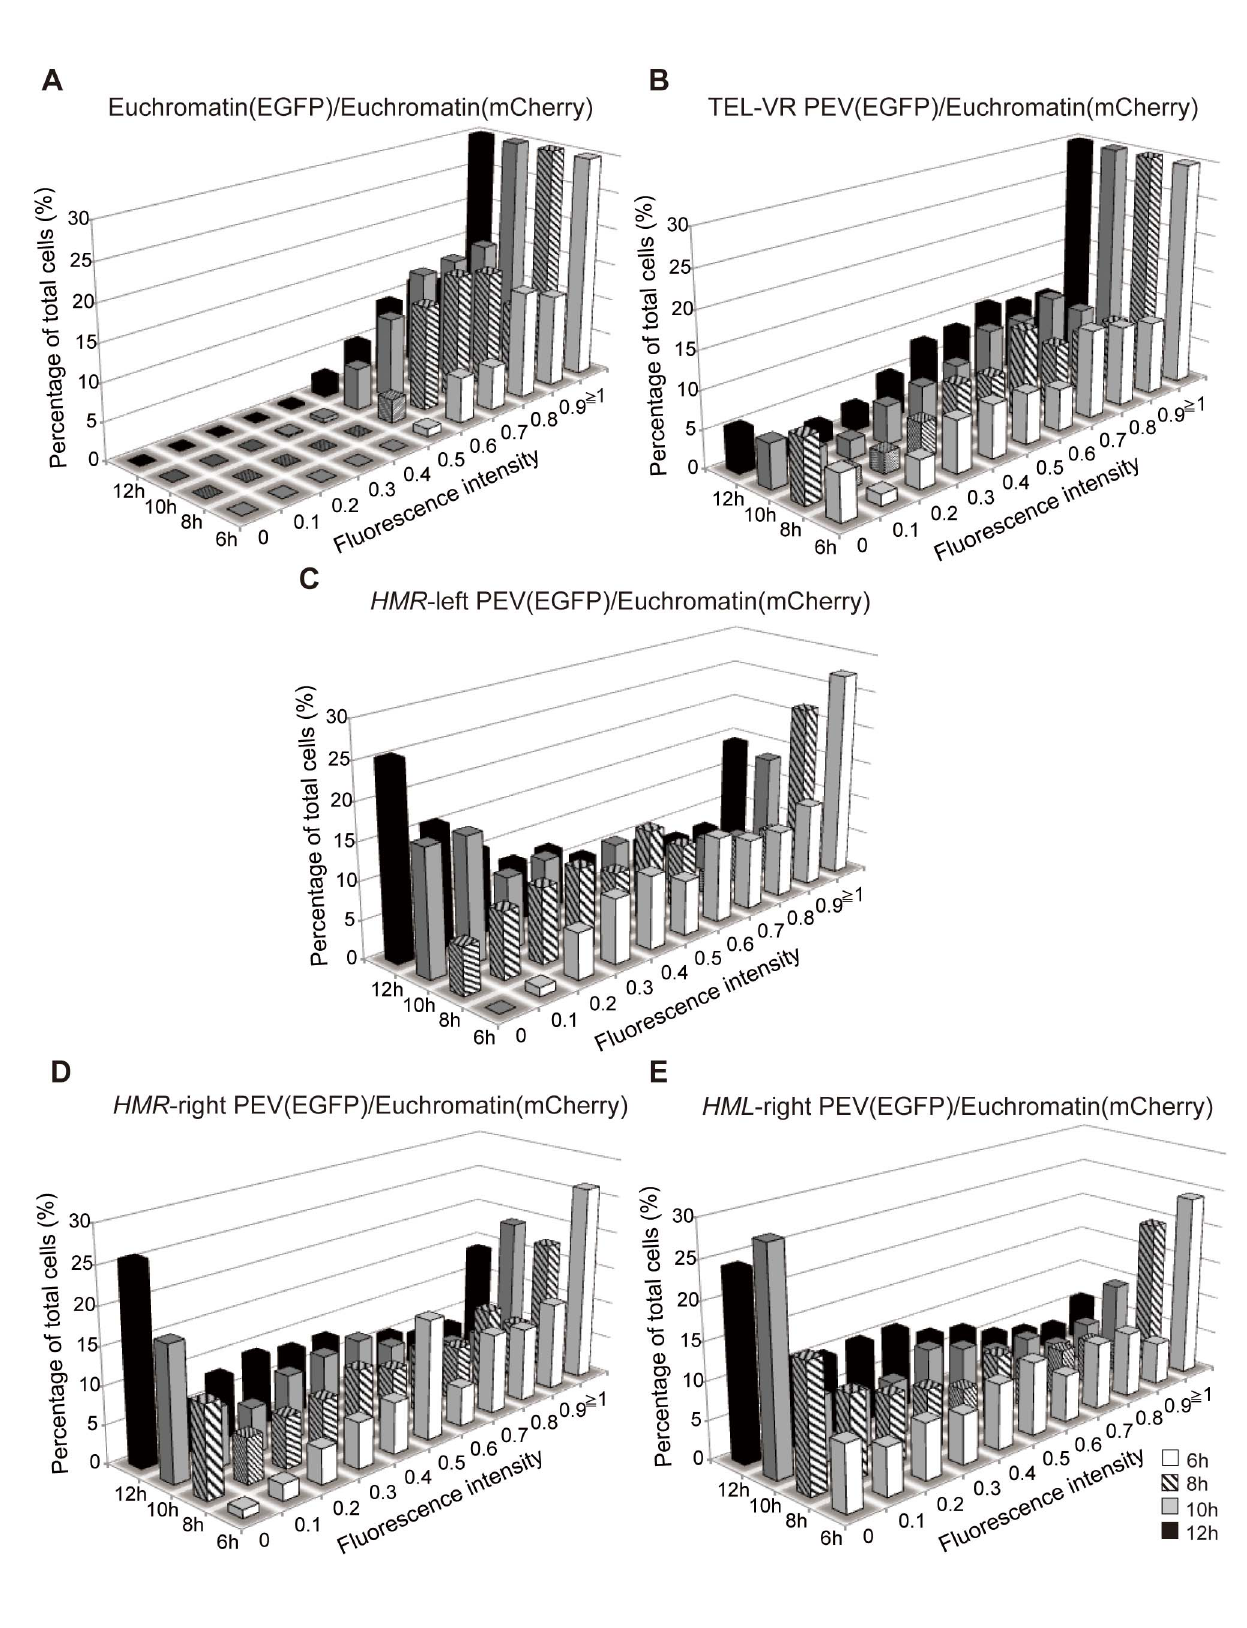
Figure 4. Fluorescence intensity at different time points in the extended time-lapse experiments. (A 2 E) Histograms showing the fluorescence intensities of the Euchromatin/Euchromatin (FUY257) (A), TEL-VR PEV/Euchromatin (FUY355) (B), HMR -left PEV/Euchromatin (FUY263) (C), HMR -right PEV/Euchromatin (FUY356) (D), and HML -right PEV/Euchromatin (FUY795) (E) cells in the field of vision at 6, 8, 10, and 12 h. Data PLOS Biology |